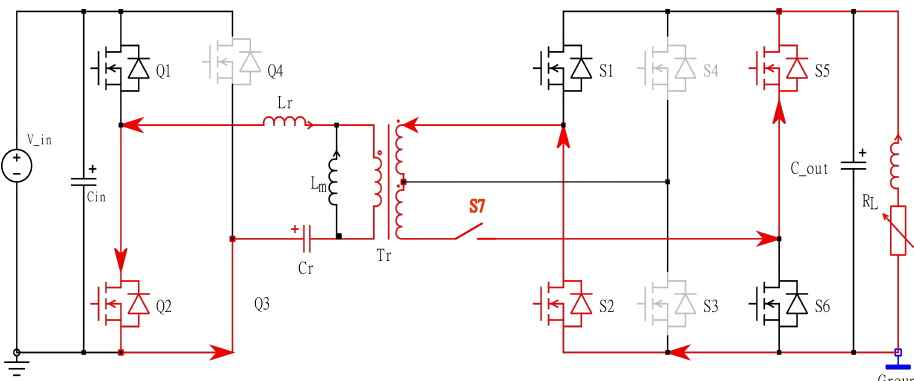
Figure 5. Fault-case: direction of current flow during negative excitation voltage on the resonant network.